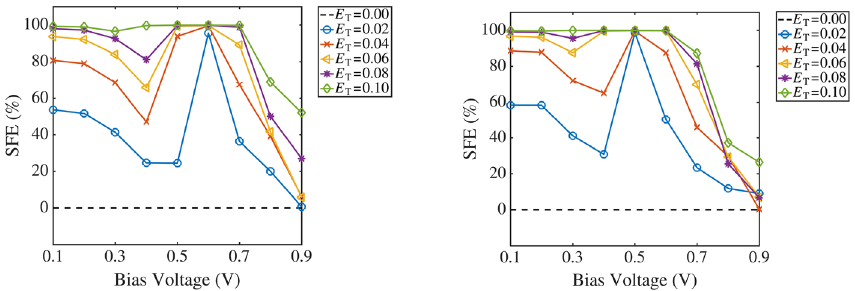
Figure 5. Spin filter efficiencies of the 6-zGNR (left) and the 8-zGNR (right) as a function of the transverse electric field, in units of of V / Å .